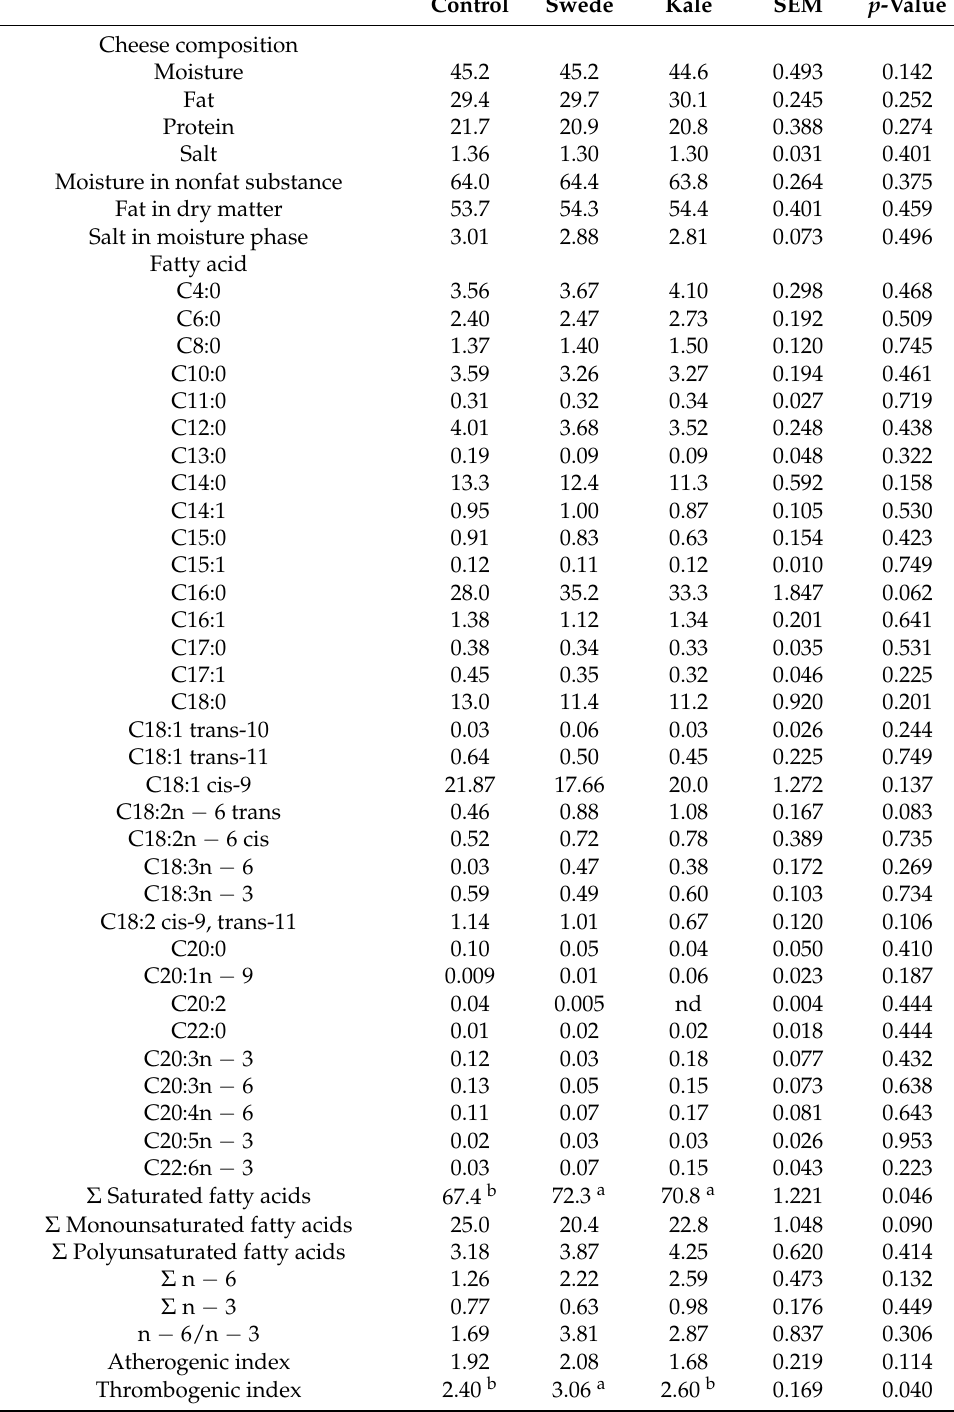
Table 4. Composition (g/100 g) and fatty acid profile (g/100 g of total fatty acids) of Chanco-style cheeses made with milks from early lactation dairy cows fed control or supplemented with kale or swedes. Control Swede Kale SEM p -Value Cheese composition